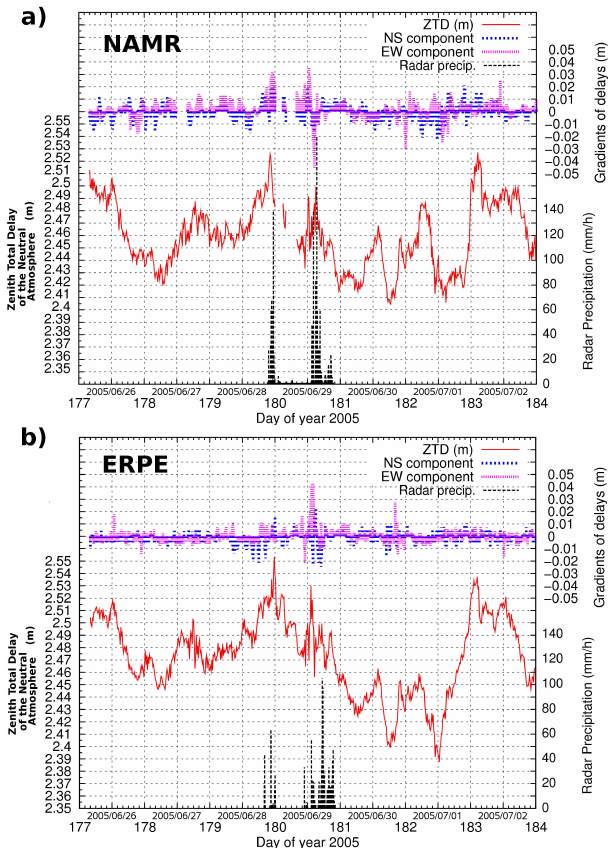
Figure 9. Time series of GNSS zenith total delays of the neu- tral atmosphere (ZTD), GNSS horizontal delay gradients (NS and EW components), and radar precipitation for (a) NAMR station (missing data the morning of 29 June) and (b) ERPE station, from 25 June 2005 to 3 July 2005.